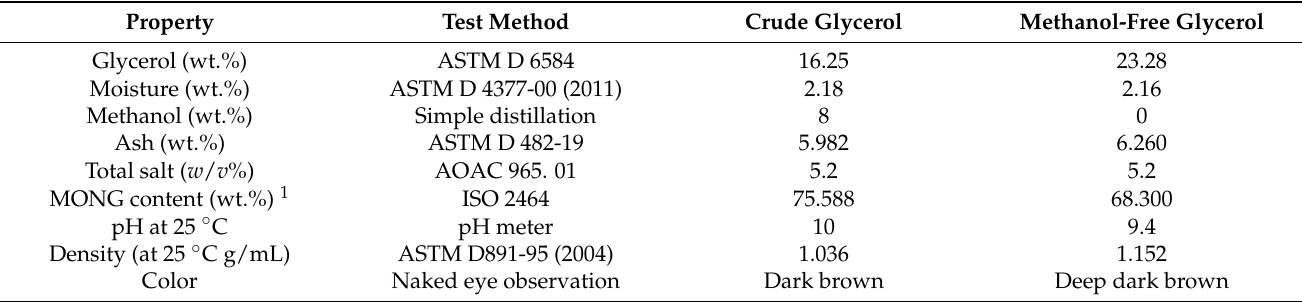
Table 2. Properties of crude glycerol and methanol-free glycerol.